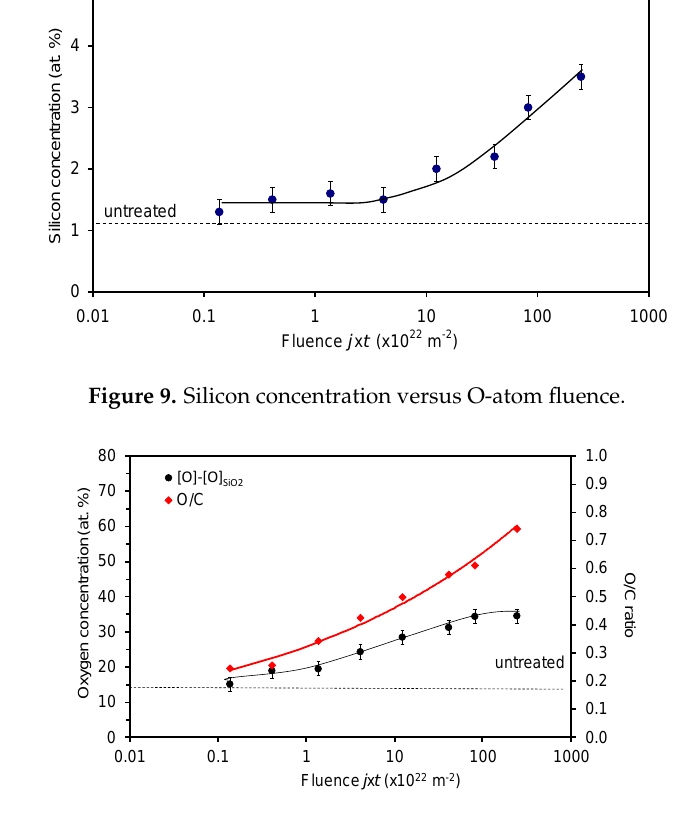
Figure 10. Variation of the oxygen concentration and the O/C ratio on the acryl-coated PP polymer surface with the O-atom fluence for the case when oxygen bonded to silicon is subtracted.